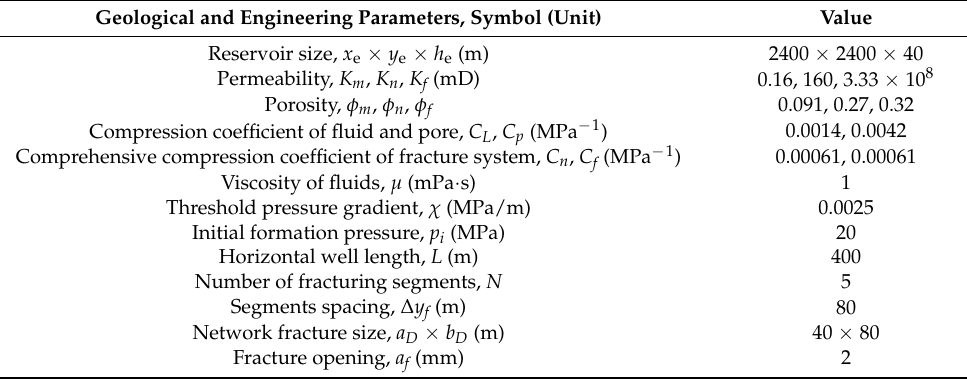
Table 1. Geological and engineering parameters of the ZP1 well in the Longdong oilfield. Geological and Engineering Parameters, Symbol (Unit)